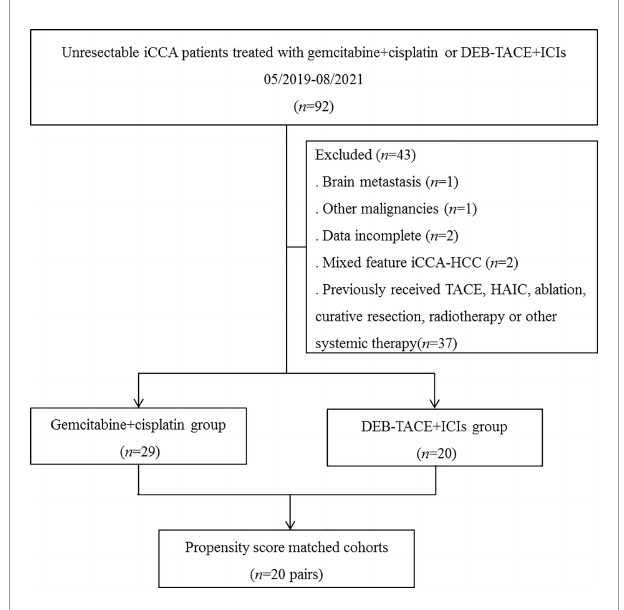
FIGURE 1 | Flow diagram of patient enrollment. iCCA, intrahepatic cholangiocarcinoma; DEB-TACE+ICIs, drug-eluting beads transarterial chemoembolization combined with immune checkpoint inhibitors; TACE, transarterial chemoembolization; HAIC, hepatic arterial infusion chemotherapy.